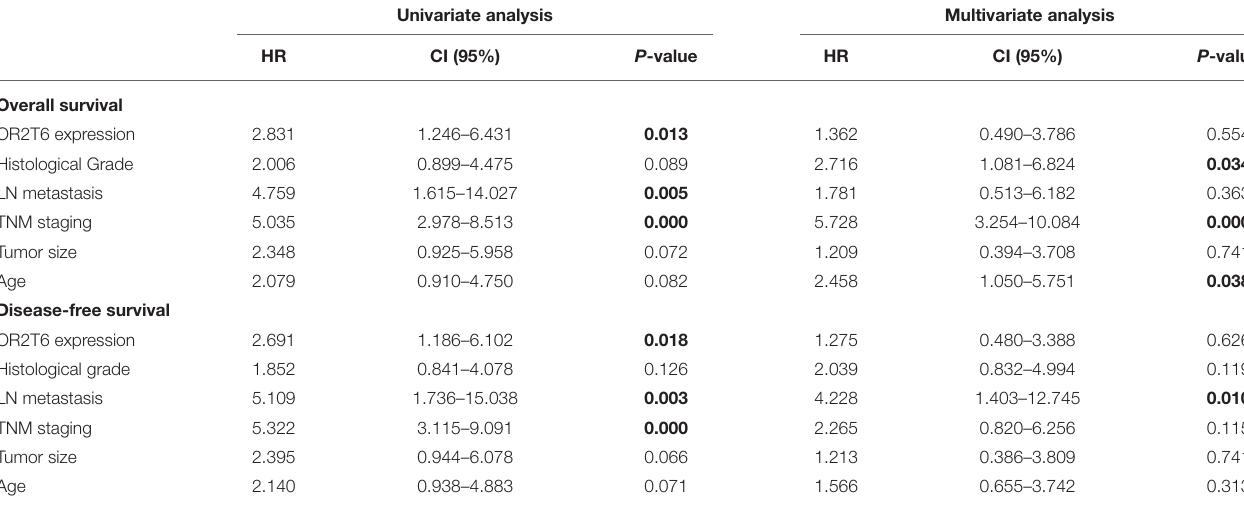
TABLE 3 | Univariate and multivariate Cox proportional hazards regression analysis of survival in 102 patients with breast cancer.